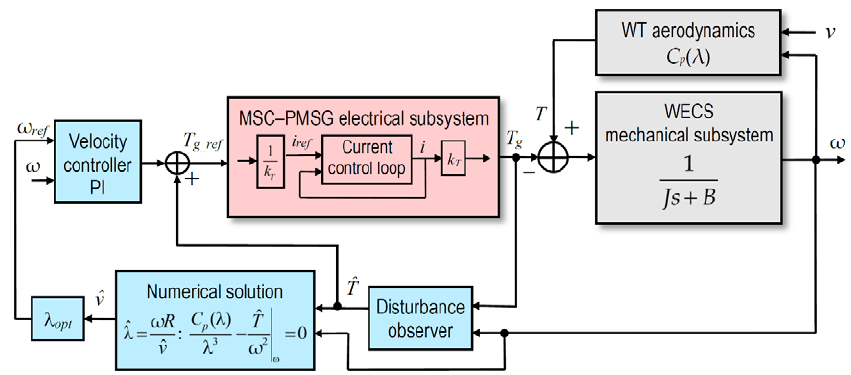
Figure 6. Proposed maximum power point tracking (MPPT) control scheme for a WECS with one-mass mechanical model and functional approximation of the power coefficient curve. The details of the angular velocity and the current/torque controllers are shown in Figure 9.